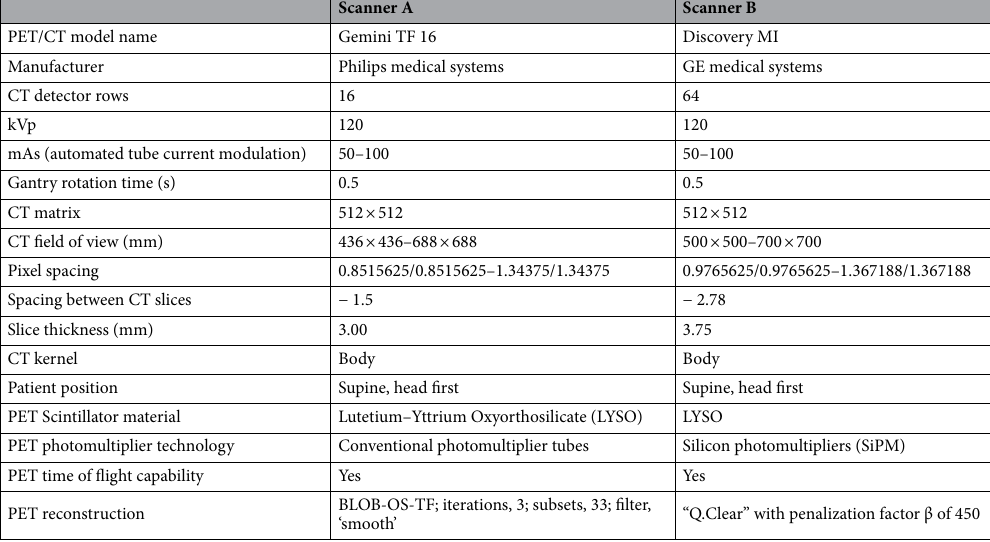
Table 3. Scanner and PET/CT scanning details. CT scanning parameters used for examinations on the two different PET/CT-scanners included in the study. kVp peak kilovoltage, mAs milliampere-seconds.